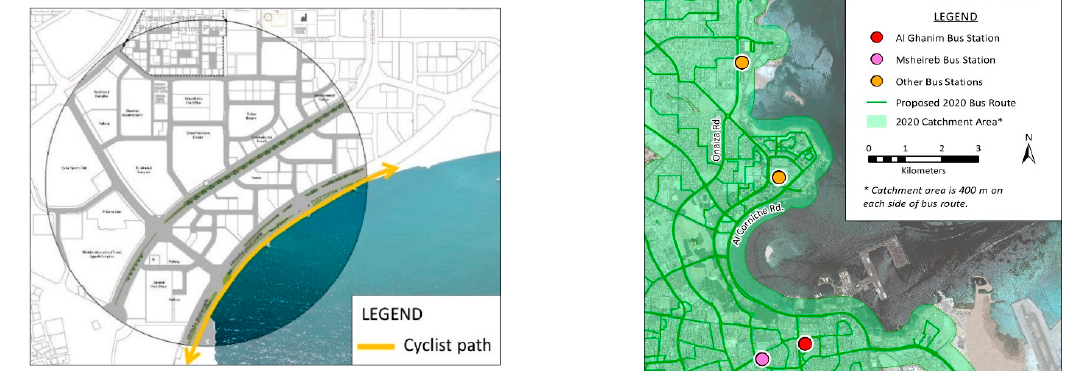
Figure 21. ( left ) Bicycle path at the study site; ( right ) bus catchment area (Source: the Authors).